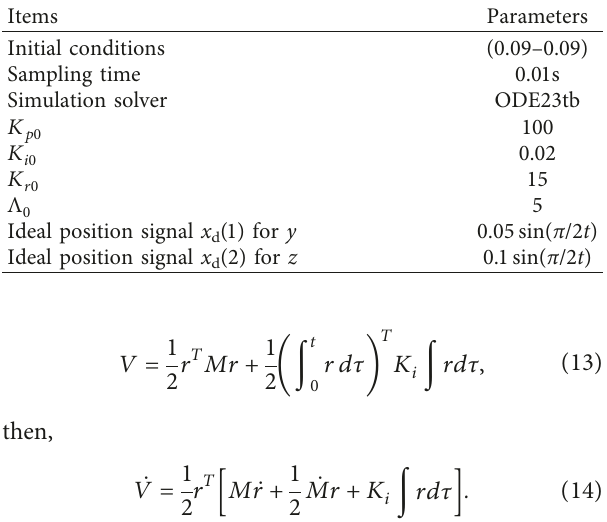
Table 2: Simulation parameters and controller